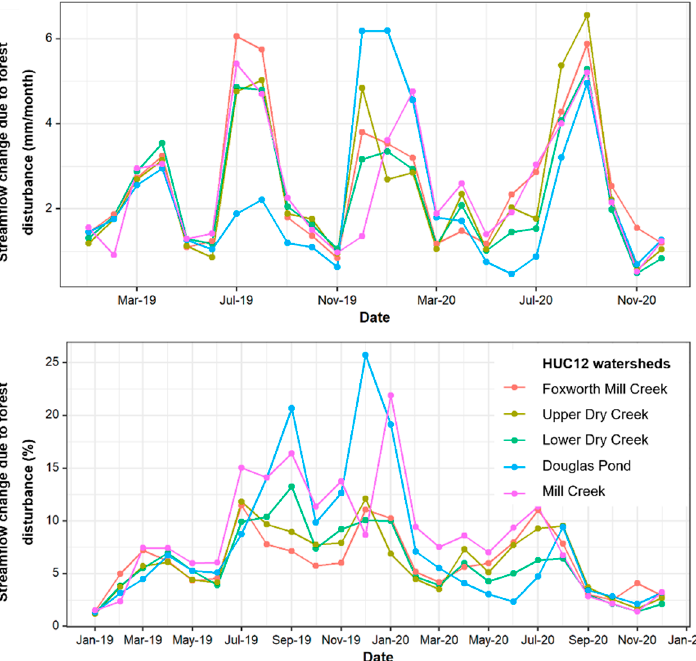
Figure 12. WaSSI modeled effects of Hurricane Michael on monthly flow for five HUC12 due to a